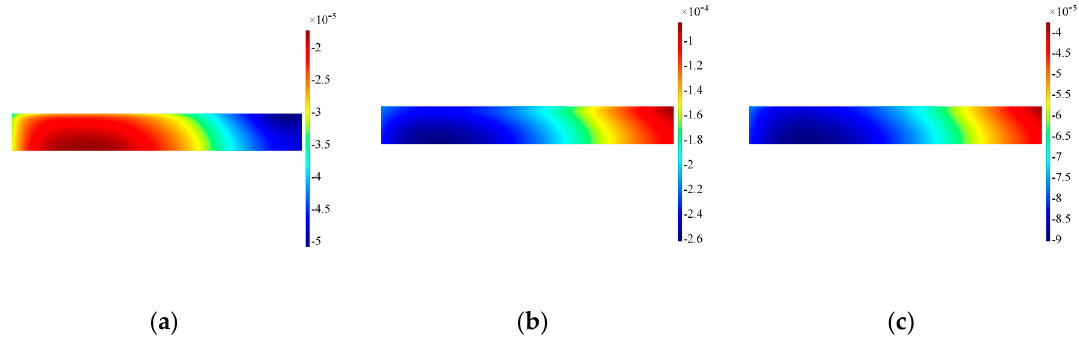
Figure 11. Surface plot for in-plane velocity on the alumina wear-plate, Configuration A. Note that data are plotted at timeframes of 100 μ s ( a ), 300 μ s ( b ) and 500 μ s ( c ).